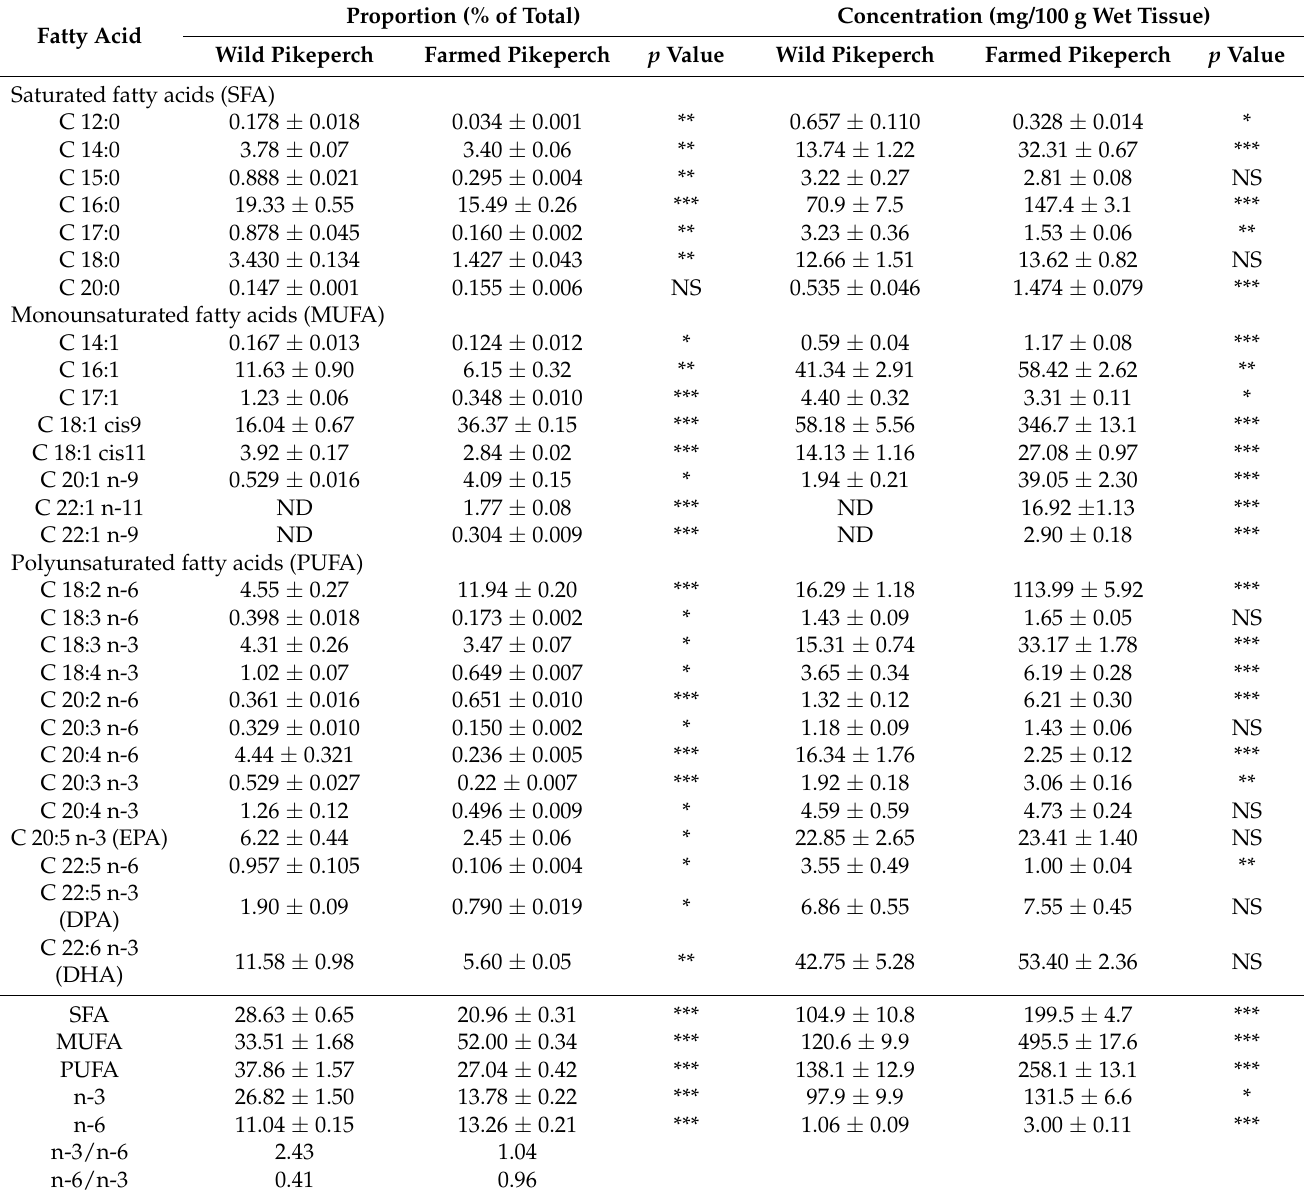
Table 6. Fatty acid composition of sous-vide wild ( n = 12) and farmed ( n = 12) pikeperch fillets (mean values ± standard